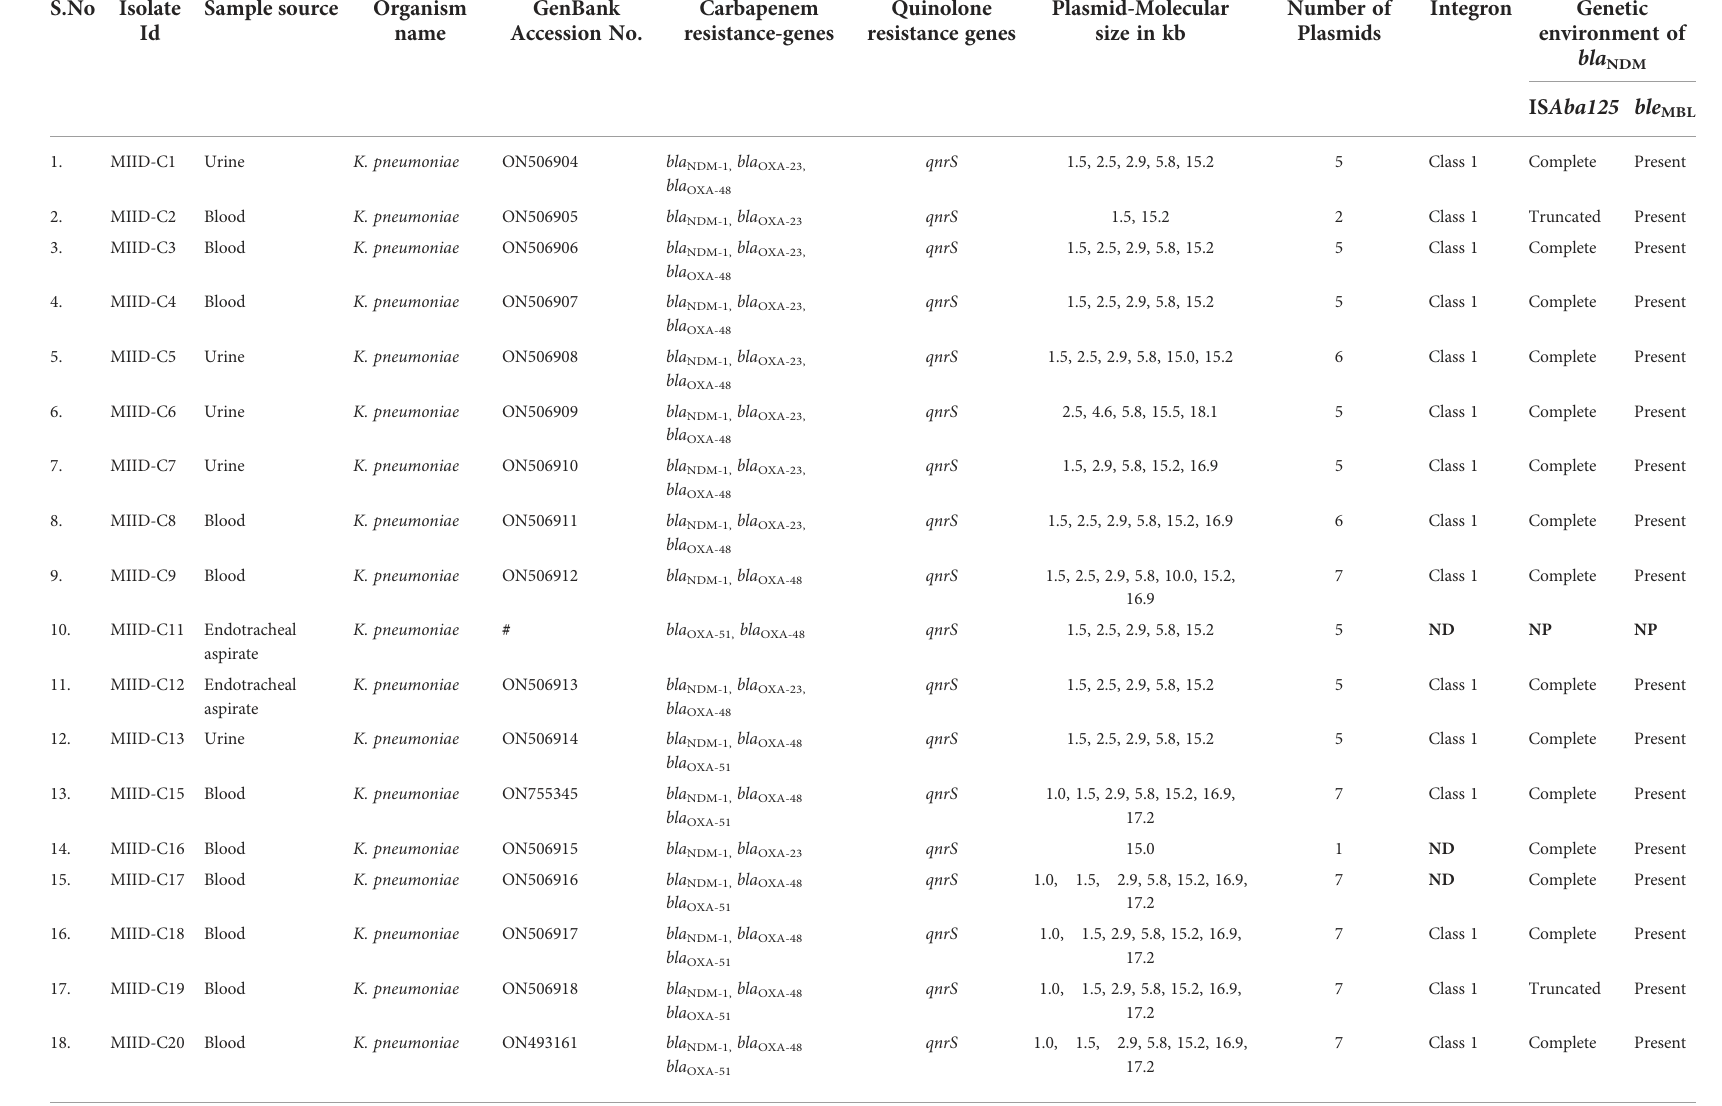
TABLE 2 Genetic characterization of carbapenem-resistant Klebsiella pneumoniae (CRKP) clinical